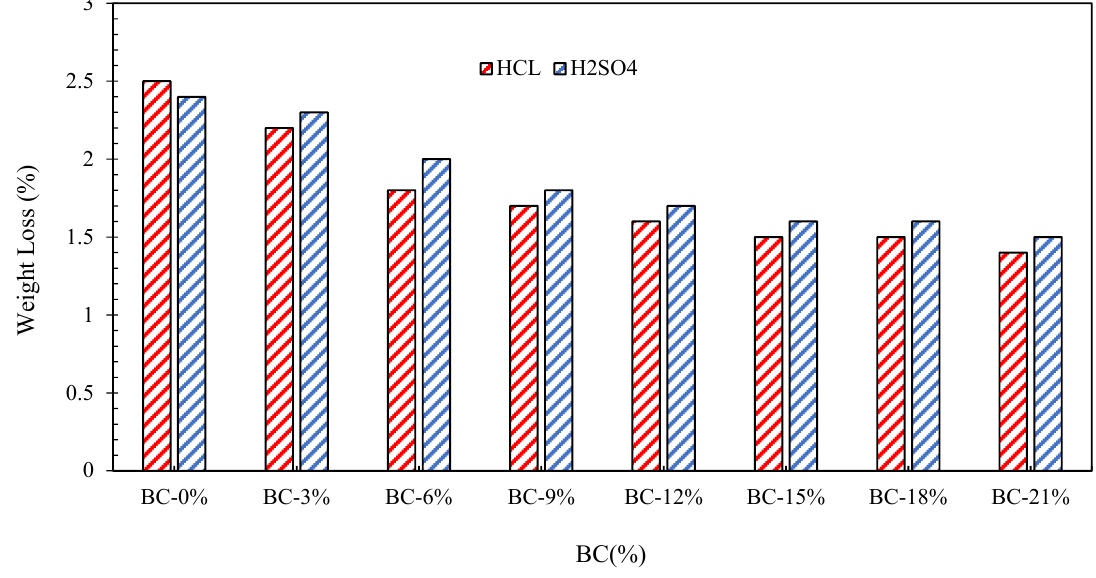
Figure 15. Acid resistance (data source [44]).